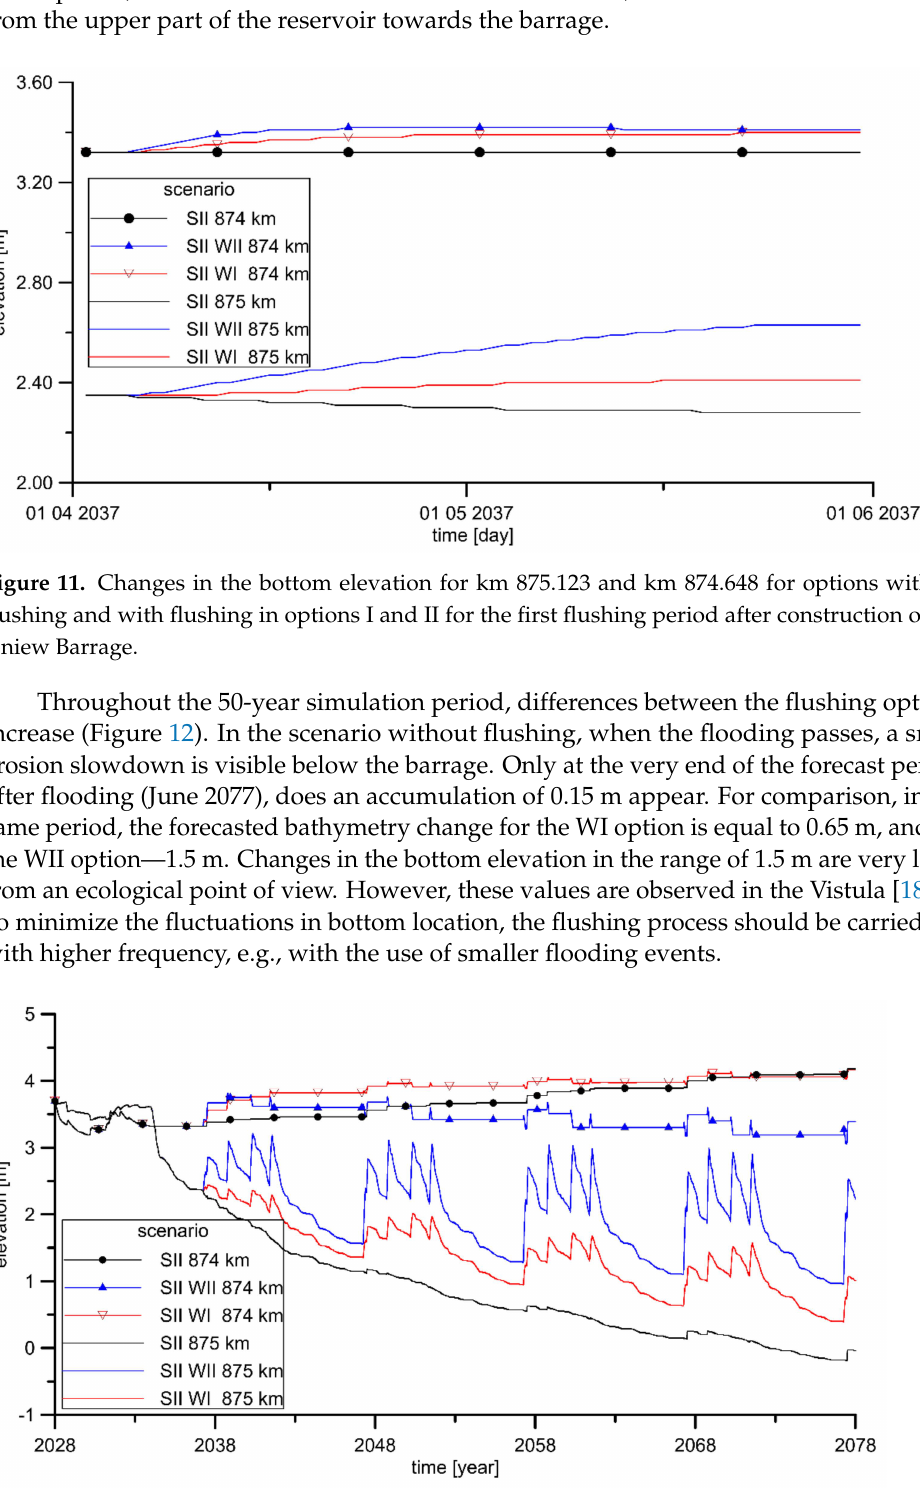
Figure 12. Changes in the bottom elevation for km 875.123 and km 874.648 for options without flushing and with flushing in option I and option II for a period of 50